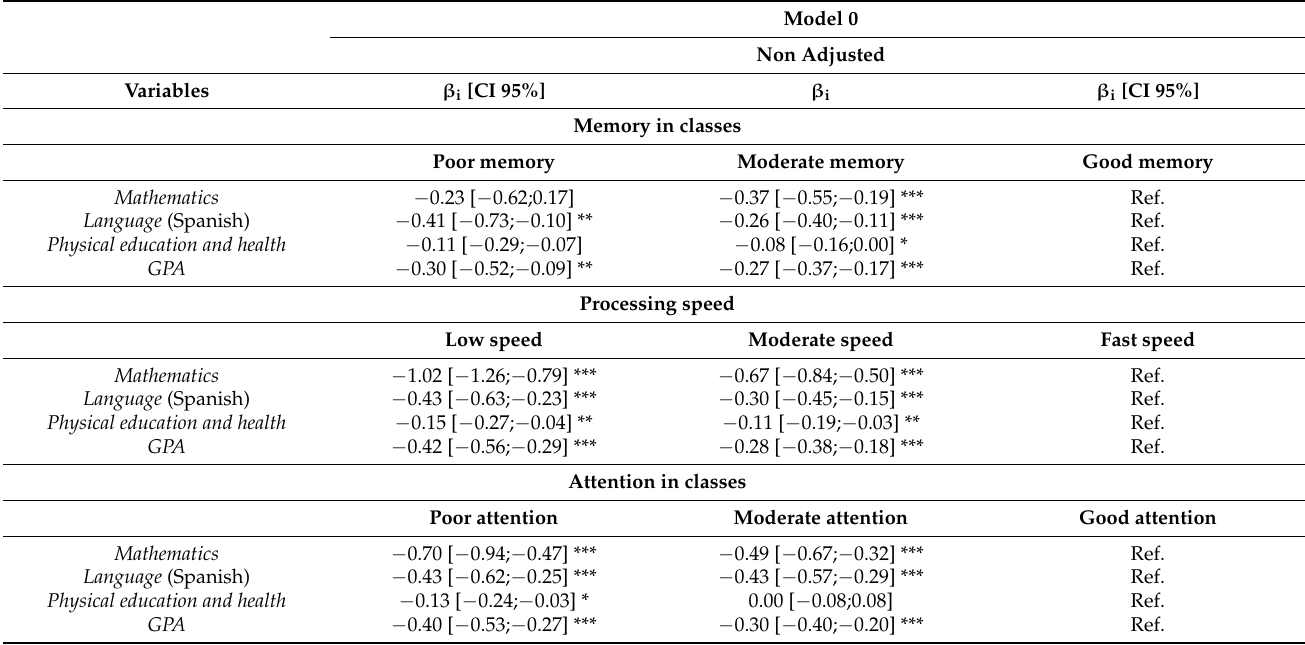
Table 4. Relationship among Mathematics, Language (Spanish), physical education and health, GPA, and perception of cognitive functions in educational